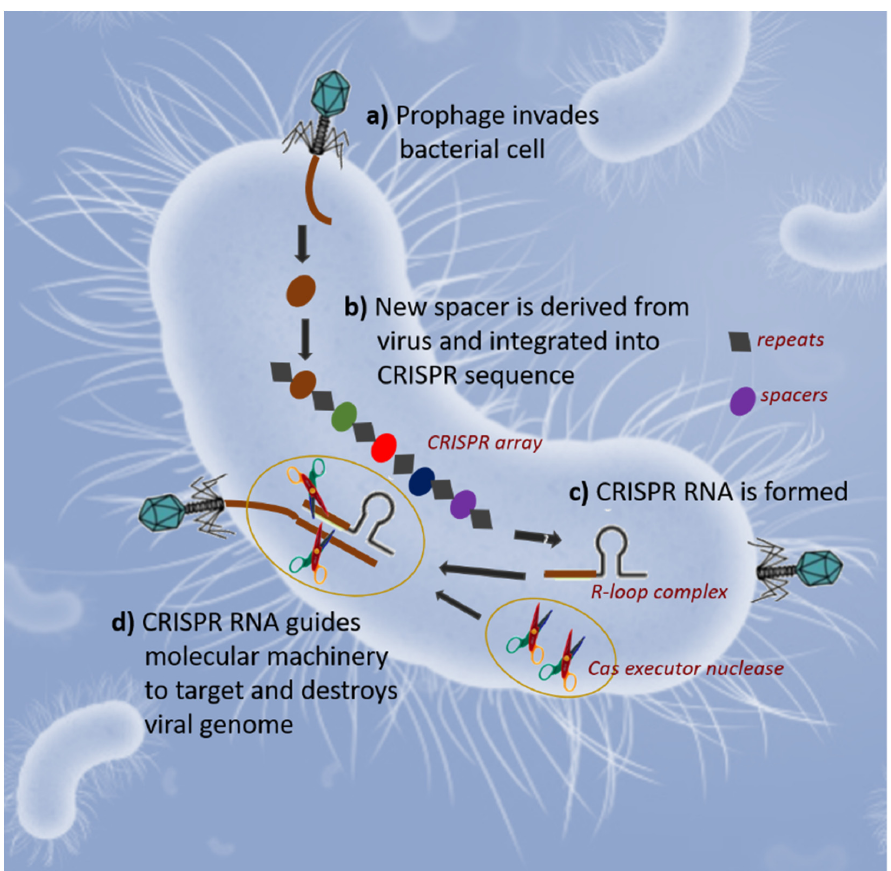
Figure 1. Schematic representation of the three stages of the CRISPR/Cas bacterial adaptive immune system: Injection of phage DNA into bacterial cell and integration into CRISPR sequence ( a , b ); CRISPR RNA biogenesis ( c ); Invader silencing ( d ). Adapted from Semenova and Severinov [31].